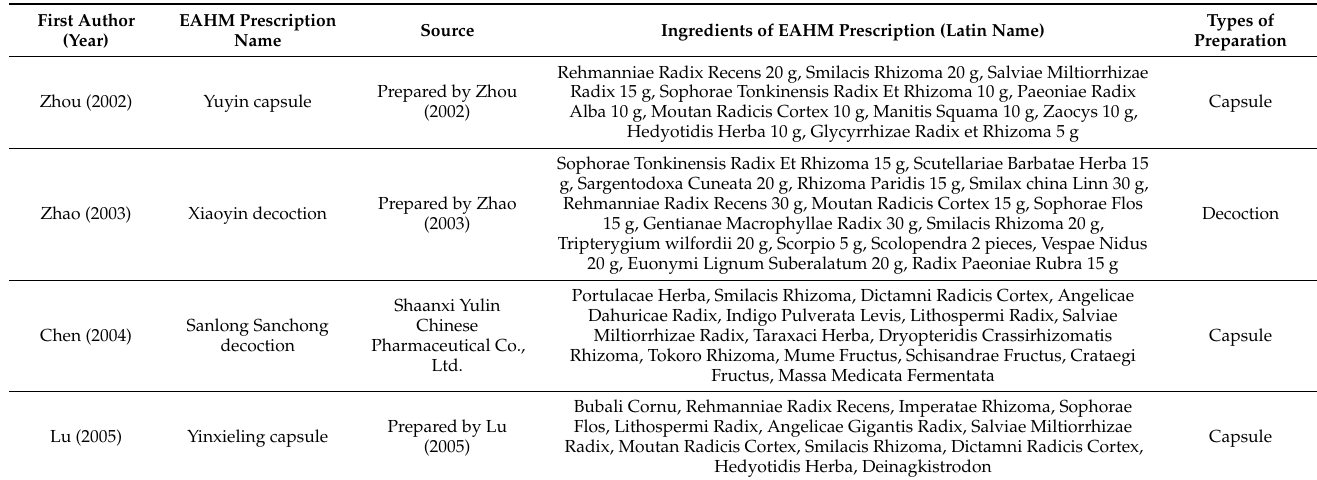
Table 5. The ingredients of EHAM used in the included